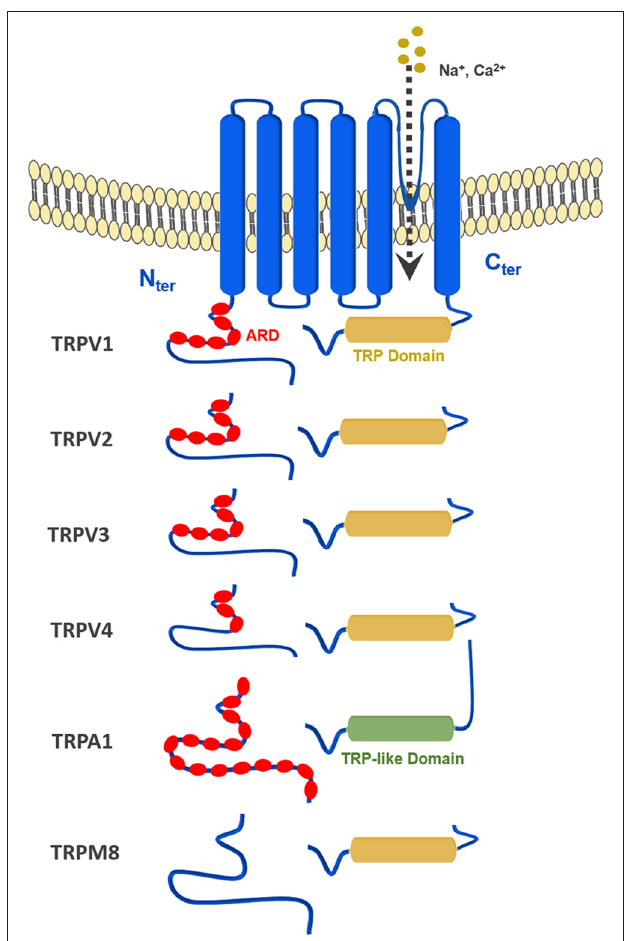
FIGURE 1 | General topology of the transient receptor potential (TRP) channels discussed in this review: TRPV1–4, TRPA1 and TRPM8.